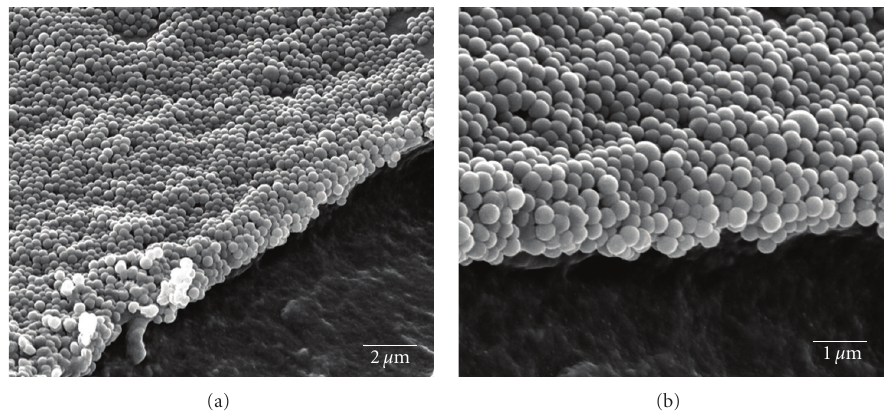
Figure 6: ESEM images of 200 nm biotin NPs layered with GOx-avidin at introduced cuts showing the layering of NPs.